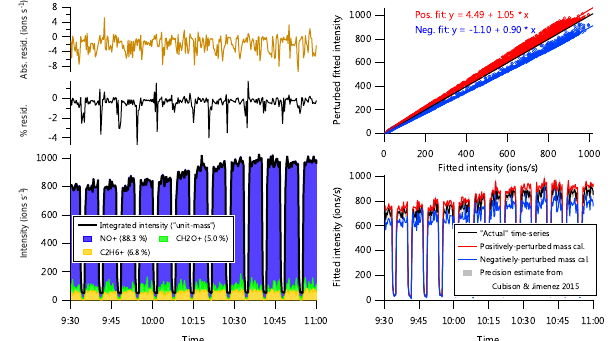
Figure 8. Assessing the sensitivity of the fitted peak intensity of the NO + ion as a function of time to perturbations in the mass cal- ibration of ± 20ppm. Left: the sum of the ions fitted at this peak compared with the integrated signal (bottom) and the absolute and relative residuals (top). Top right: scatter plots of the fitted NO + signals for the perturbed vs. best-case mass calibration scenarios. Bottom right: time series of the fitted NO + intensities, with the per- turbed mass calibration cases shown in red and blue. The shading around the black line indicates the expected precision predicted by the parameterisation of Cubison and Jimenez